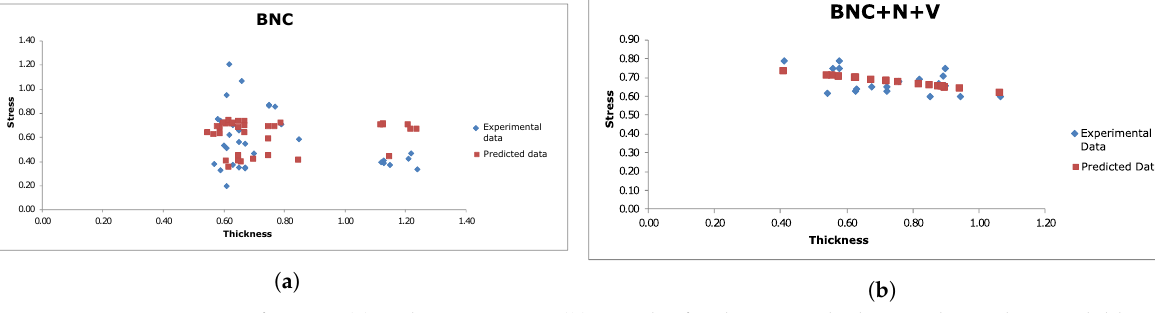
Figure 9. Linear regression for BNC ( a ) and BNC + N + V ( b ) samples for the stress–thickness relationship. Each blue dot represents one sample. The red dots represent the result predicted by the linear regression. Reprinted from